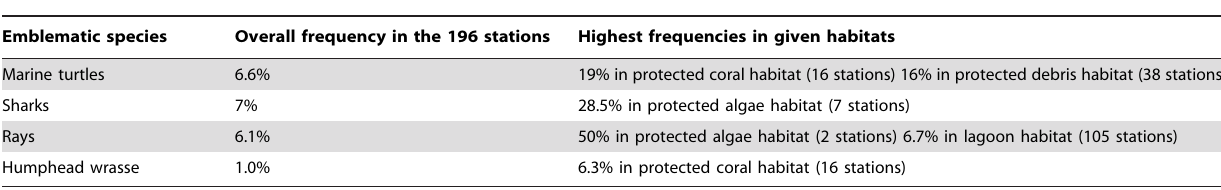
Table 5. Frequency of occurrence of emblematic species in the video stations.